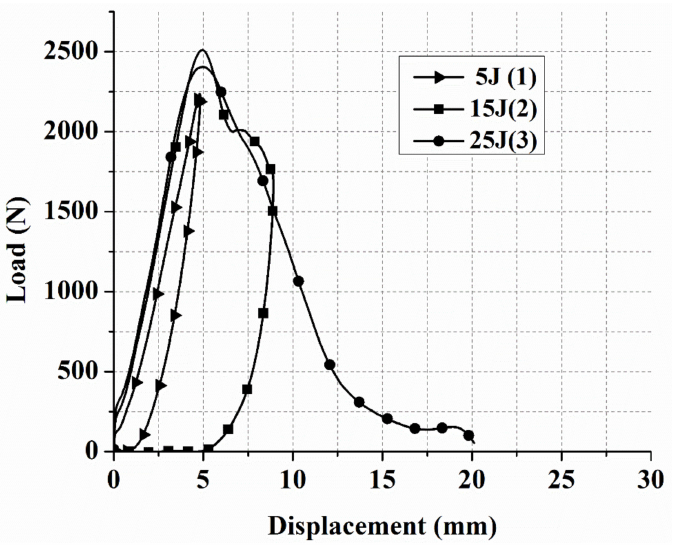
Figure 10. Load–displacement curves for low-velocity impact tests of laminate composites with [A/B] at 5, 15, and 25